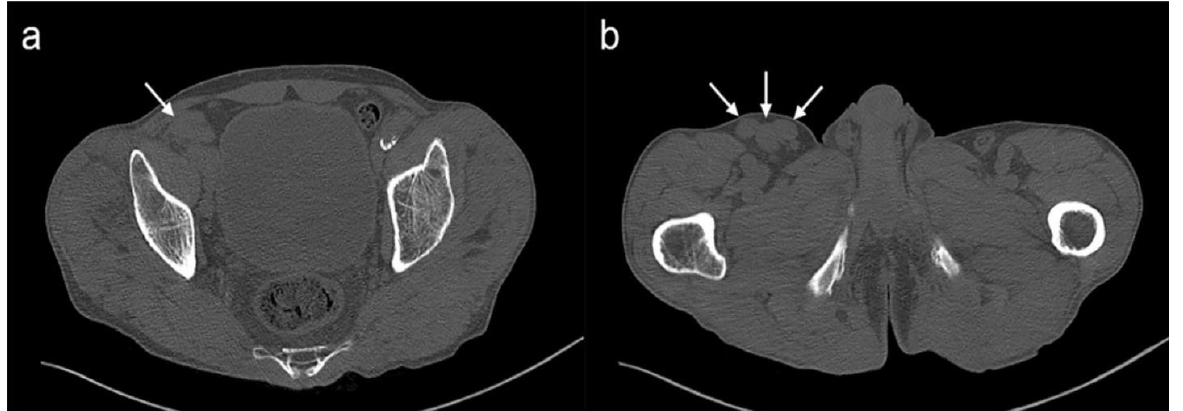
Figure 1. CT images of the lower extremity. Multiple lymphadenopathies (arrows) are seen in ( a ) right external iliac and ( b ) right inguinal areas.